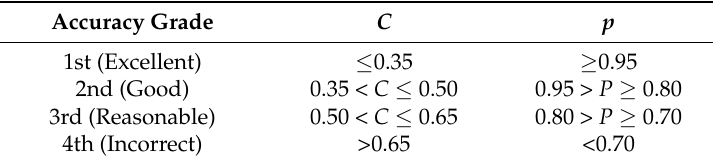
Table 5. Accuracy standard of posteriori error [22].